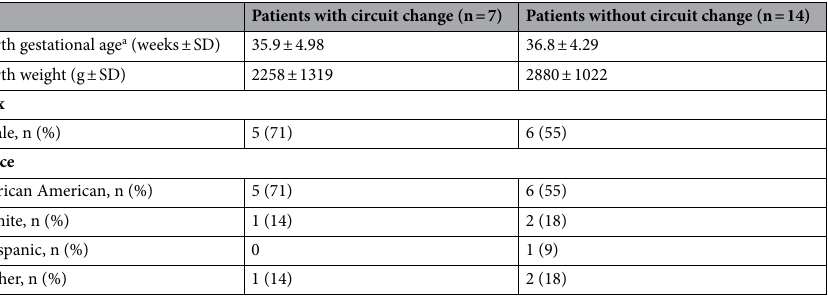
Table 1. Patients’ demographics (n = 21). a Premature infants were placed on ECMO weeks–months after birth. SD Standard Deviation.